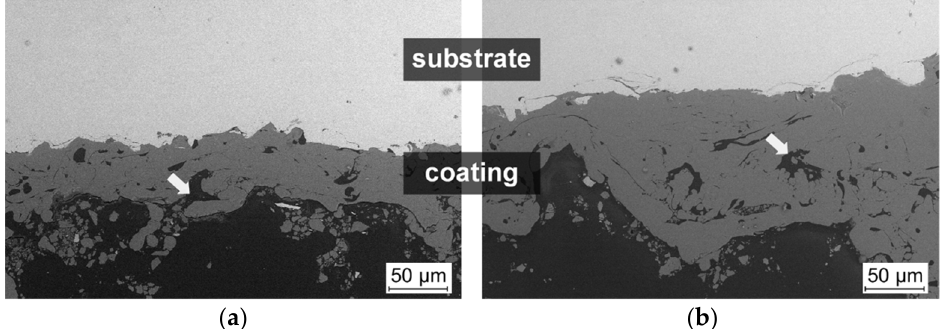
Figure 7. Representative SEM images showing the substrate on top and the coating below (specimen bottom) for the samples blasted with ( a ) corundum; ( b ) grit.